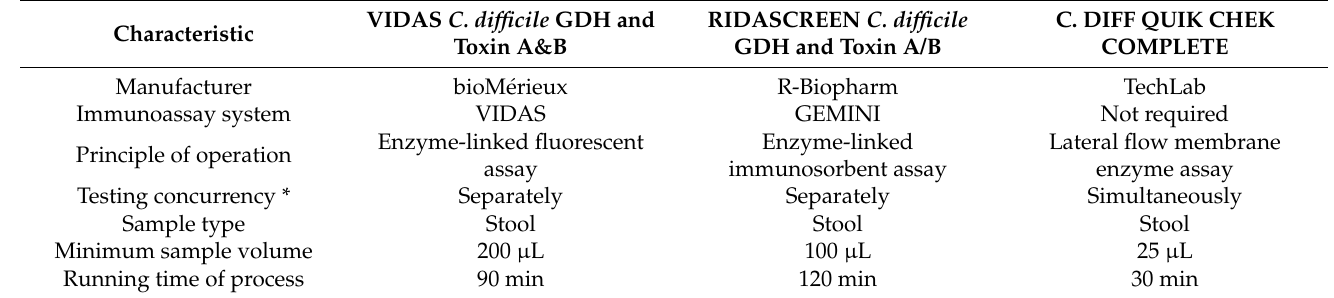
Table 1. Performance characteristic information of the three immunoassays for the detection of Clostridium difficile glutamate dehydrogenase and toxin A/B, provided by the